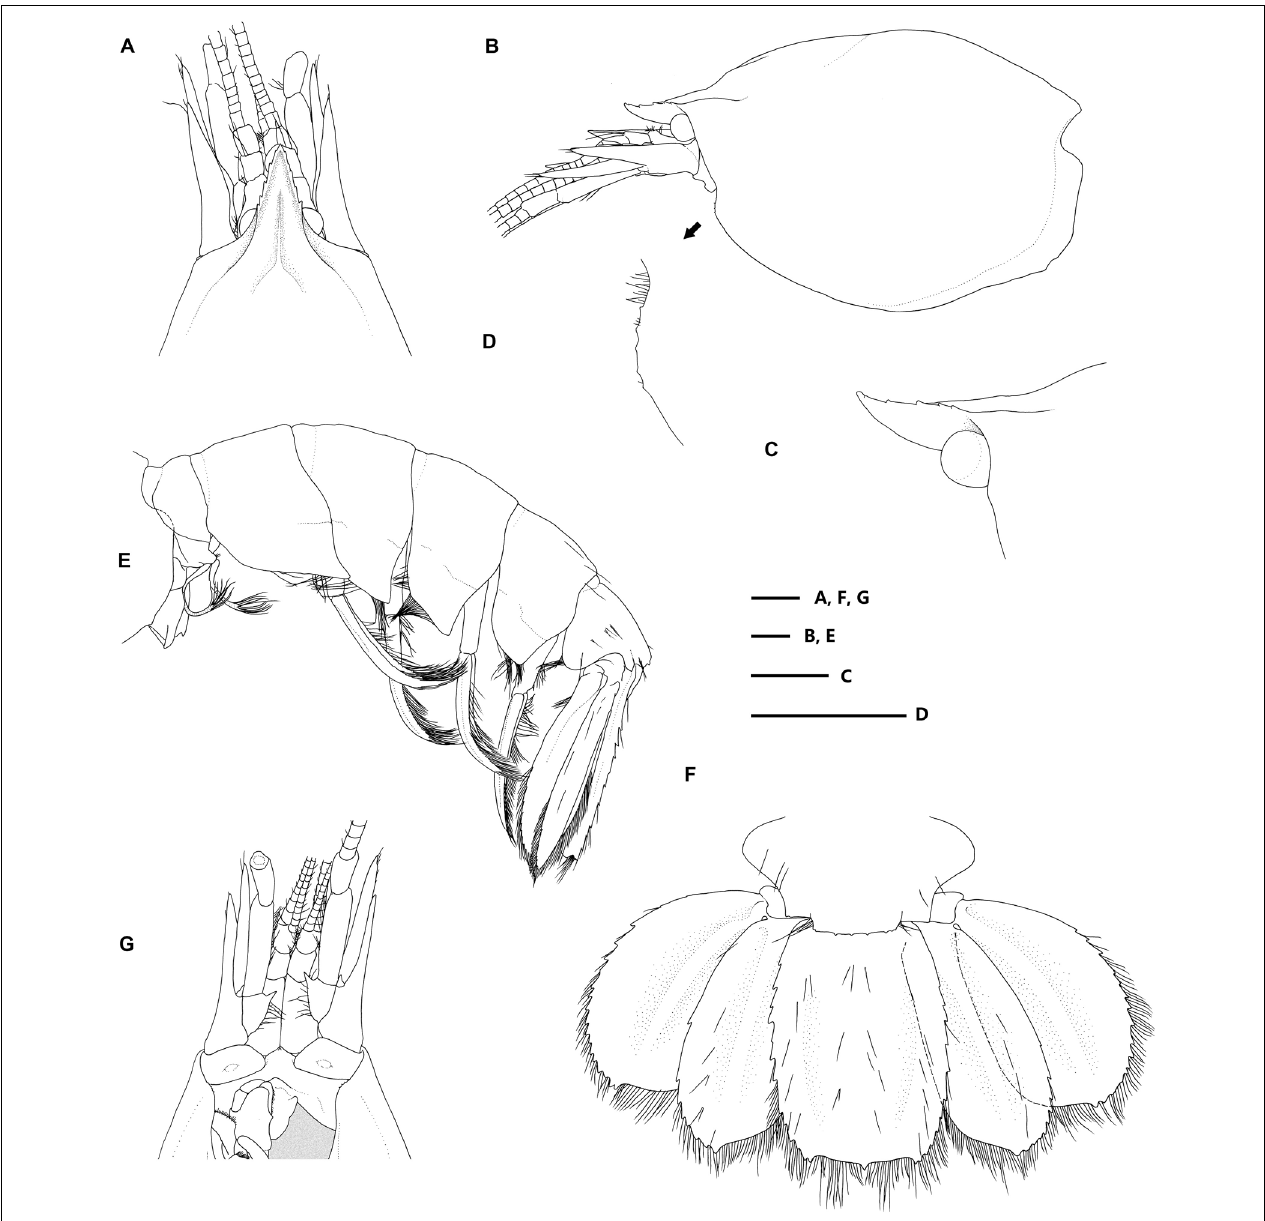
FIGURE 2 | Eiconaxius serratus sp. nov. Holotype, SRSIO 14070301 (ovigerous female, cl 9.0 mm). (A) anterior carapace, antenna, antennule, dorsal view; (B) carapace, antenna, antennule, lateral view; (C) rostrum, anterior median carina, lateral view; (D) pterygostomial angle, lateral view; (E) pleon, pleopods, telson, uropods, lateral view; (F) pleomere 6, telson, uropods, dorsal view; (G) anterior carapace, antenna, antennule, ventral view. Scales: 1 mm.